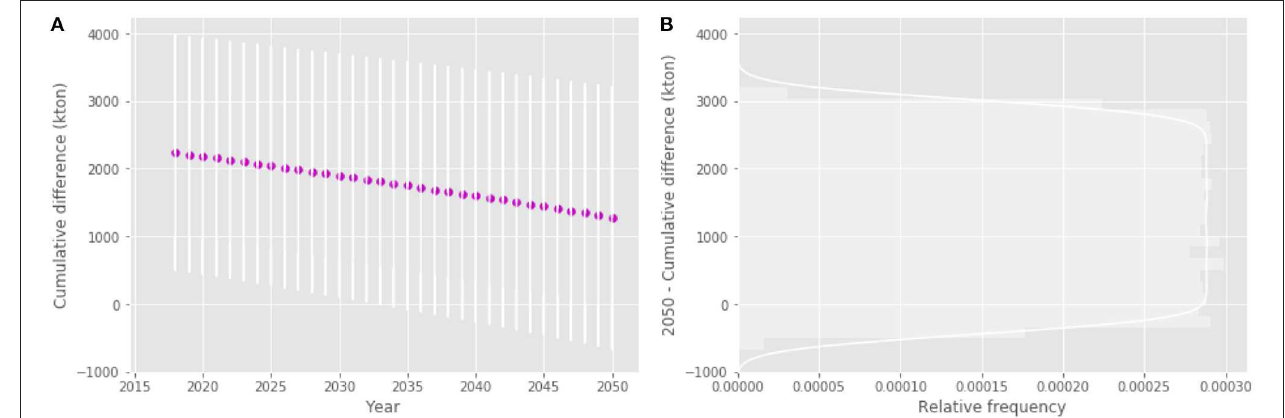
FIGURE 5 | (A) Yearly difference between silver natural budget (kton) and 80% of the cumulative silver demand over 2018–2050; Negative values correspond to a deficit (demand overshooting the natural budget). Monte Carlo simulations run on 8,192 quasi-random samples. The means of the yearly distributions are shown in magenta. (B) The distribution of the simulation outcomes for the year 2050 (cumulative silver difference against relative frequency).